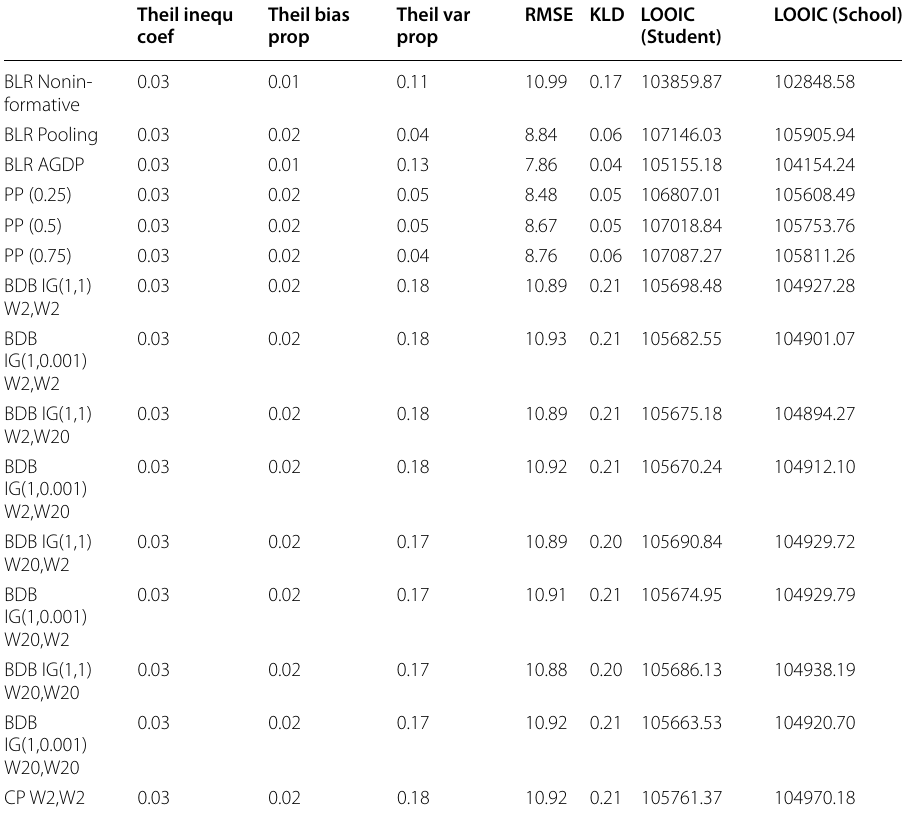
Table 5 Prediction performance of different borrowing methods for the full sample of female